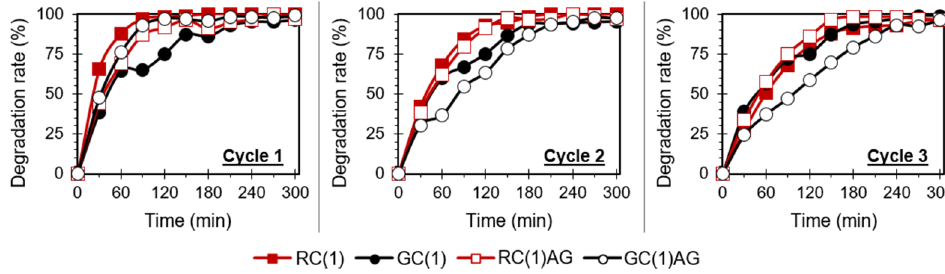
Figure 6. Photocatalysis degradation rate as a function of time for AR14 under artificial solar light in the presence of RC(1), GC(1), and RC(1)AG or GC(1)AG for 3 subsequent experimental cycles.